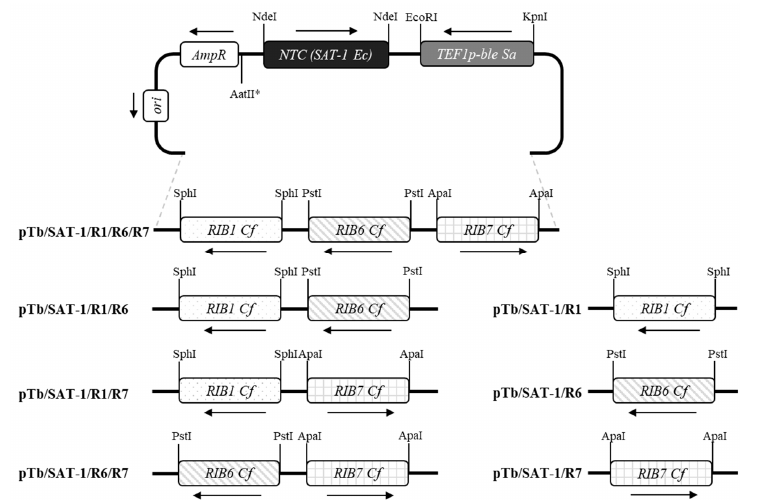
Figure 1. Circular scheme of plasmids pTb/SAT-1/R1, pTb/SAT-1/R6, pTb/SAT-1/R7, pTb/SAT-1/R1/R6, pTb/SAT-1/R1/R7, pTb/SAT-1/R6/R7, and pTb/SAT-1/R1/R6/R7 for co-expression of C. fa- mata RIB genes. All plasmids had the same plasmid backbone containing SAT-1 gene conferring resistance to nourseothricin and indicated as a black box, and gene ble under control of TEF1 pro- moter from C. famata conferring resistance to phleomycin and indicated as a dark grey box. The RIB1 gene is presented as a dotted box, RIB6 —as a striped box, and RIB7 —as a square grid box, * AatII— plasmid linearization enzyme.